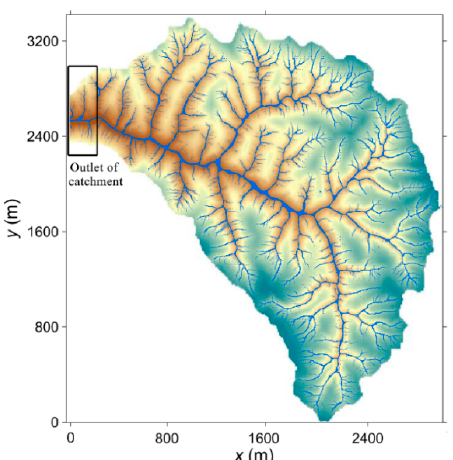
Figure 20. Inundated area of Wangmaogou catchment at the peak time of the discharge ( t = 6000 s).